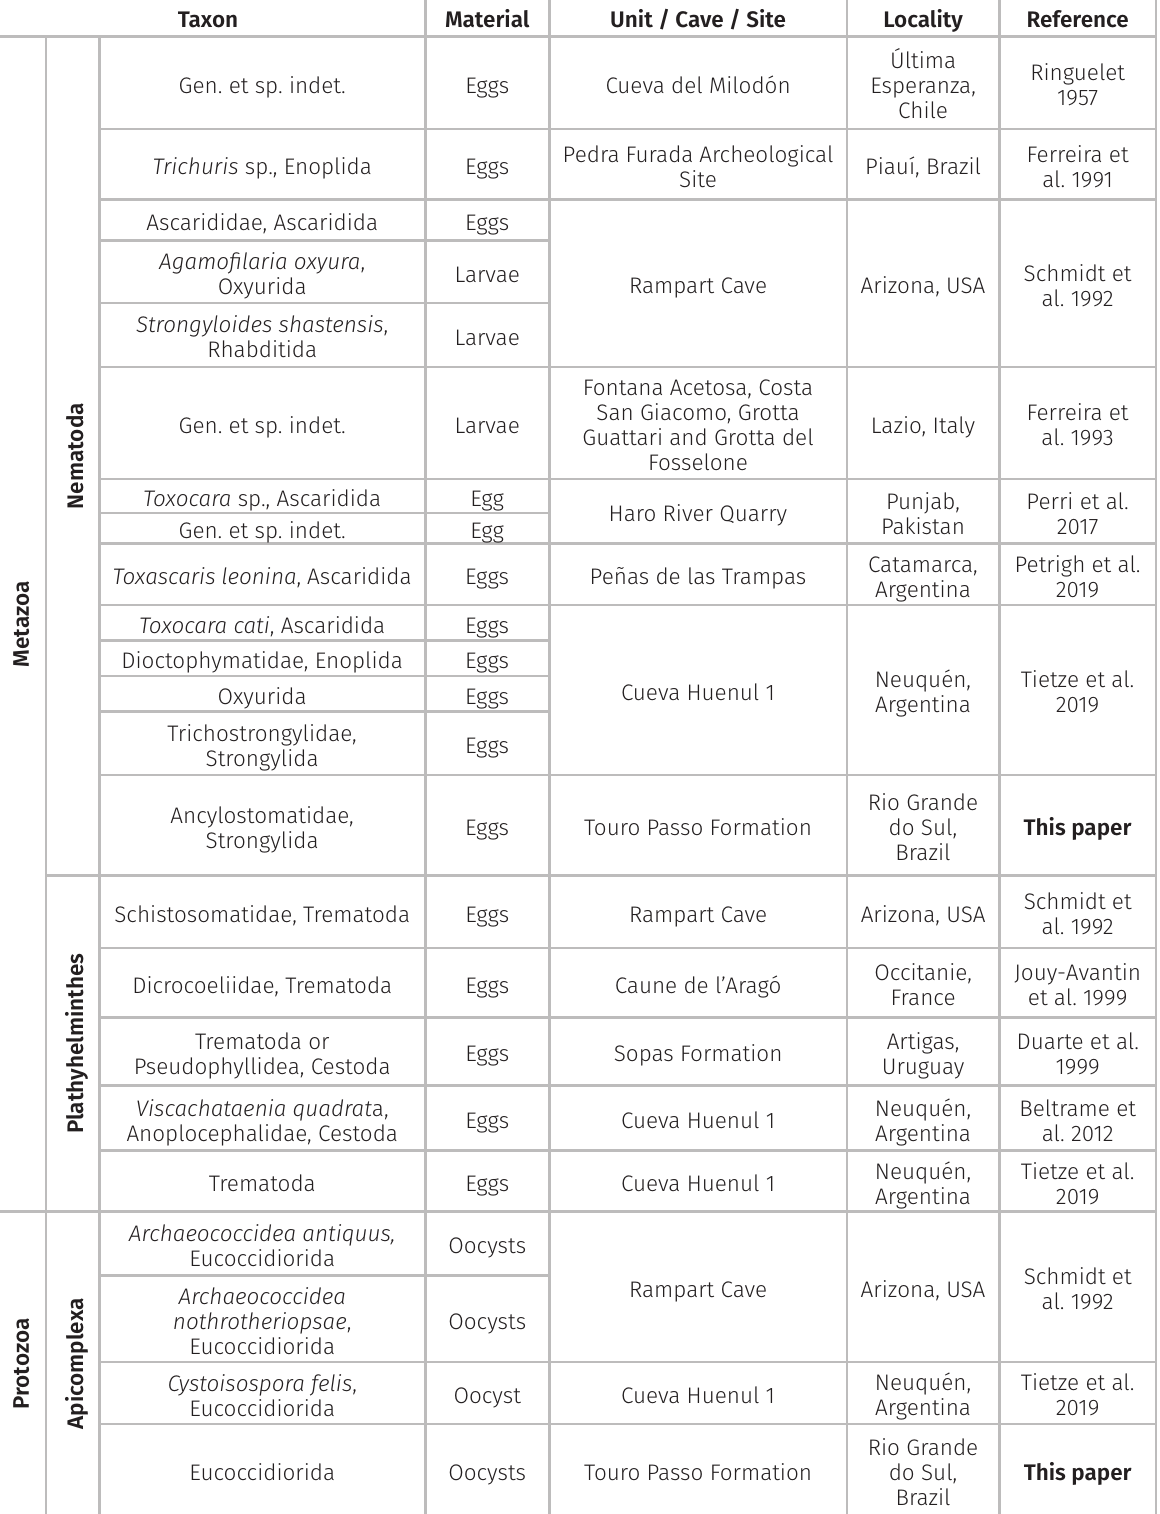
Table I. Paleoparasitological records from Pleistocene coprolites published until now.